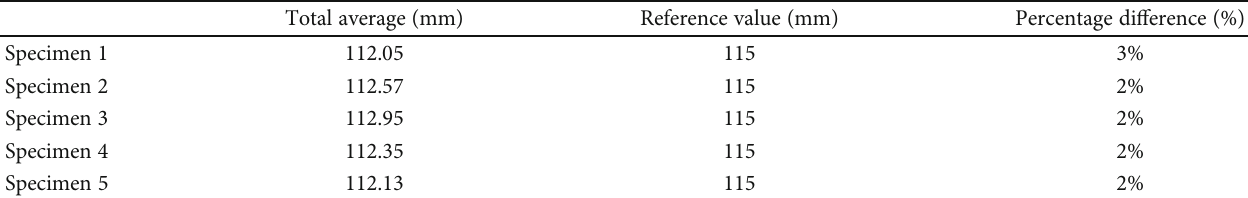
Table 10: Length ( LO ) of the test